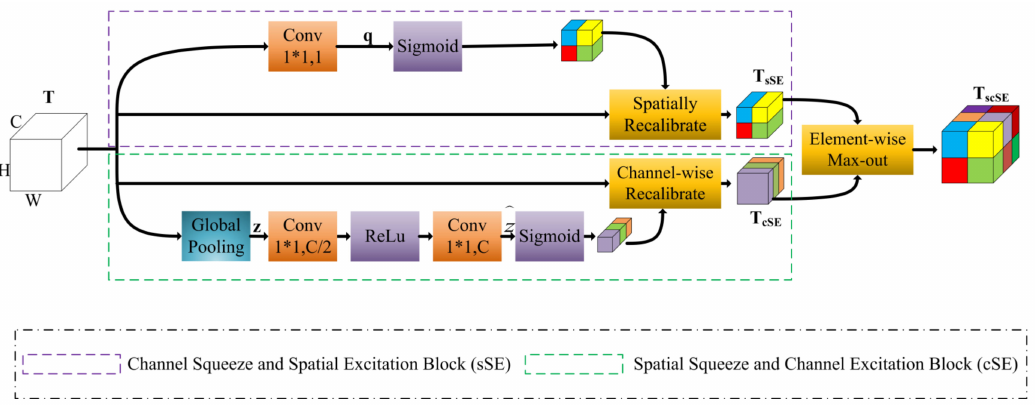
Figure 5. Spatial and Channel Squeeze and Excitation Block(scSE).